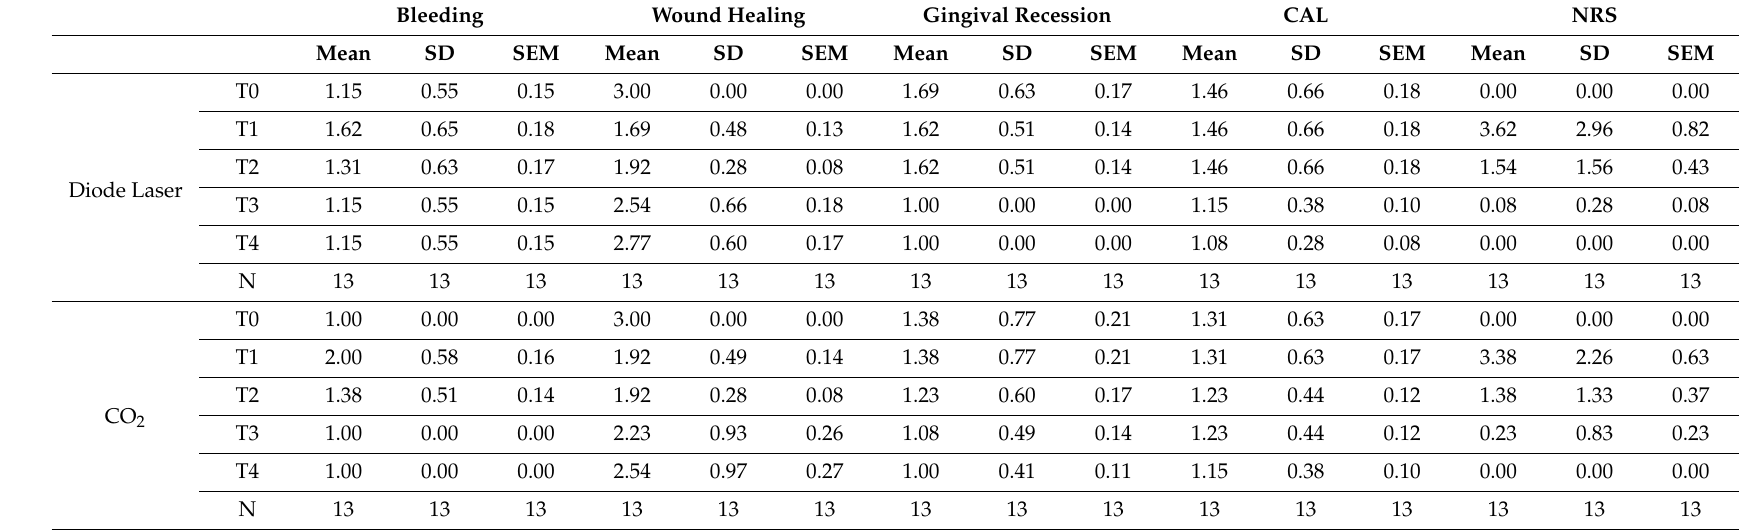
Table 3. Descriptive statistic of